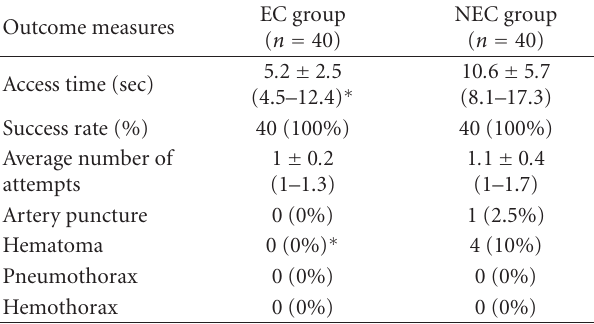
Figure 1: Subjective cannula visibility assessments (echogenic can- nula, EC: gray; nonechogenic cannula, NEC: black). Table 2: Secondary outcome measures in the EC group versus the NEC